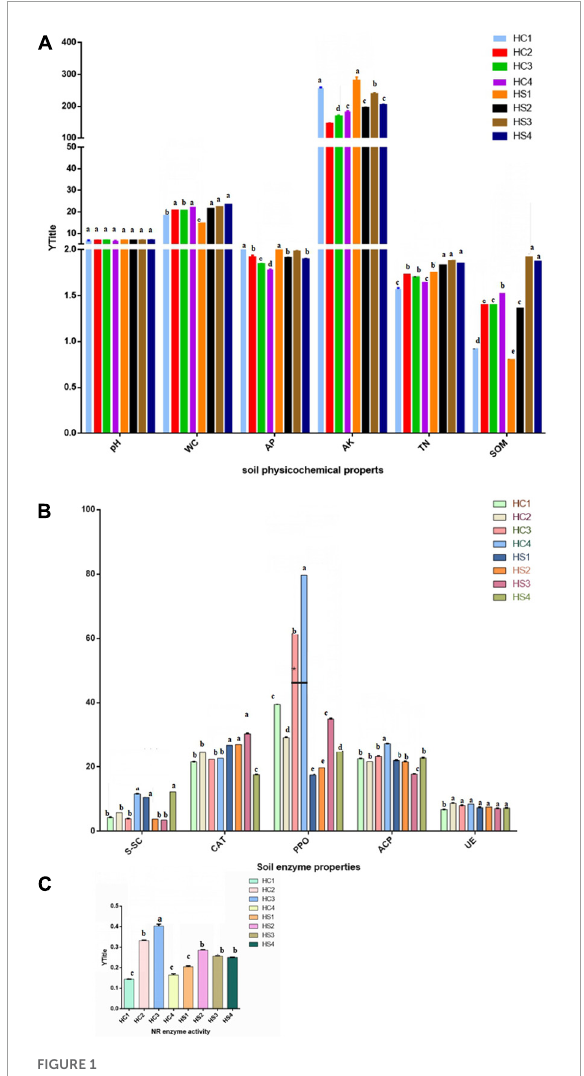
FIGURE1 Physicochemical properties of soils in two groups. (A) Effects of deep tillage on soil pH, water content (%), available phosphorus (mg · kg − 1 ), available potassium (mg · kg − 1 ), total nitrogen (g · kg − 1 ), and organic matter (g · kg − 1 ); (B) Effects of deep tillage on soil sucrase (S), catalase (CAT), polyphenol oxidase (PPO), acid phosphatase (ACP), and urease (UE) activities. (C) Effect of deep tillage on nitrate reductase (NR) activity. Two-way ANOVA was adopted to examine the significance of the data. Mean values of treatments with the same letter are not significantly different in the figure; mean values of treatments where all letters were different are significantly different ( p ≤ 0.05). Soil samples with different tillage depths (HC1 vs. HS1: 0 cm, HC2 vs. HS2: 0–10 cm, HC3 vs. HS3: 10–20 cm, and HC4 vs. HS4: 20–40